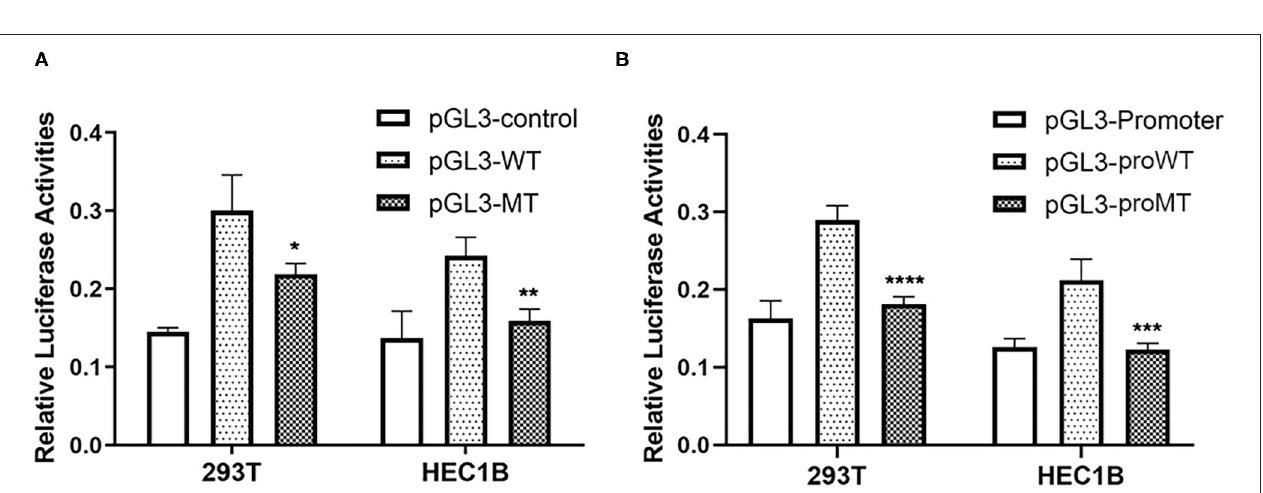
FIGURE 4 | The effect of rs72014506 on gene transcriptional activity. (A) The relative firefly luciferase activities were compared between insertion construct group (pGL3-WT) and deletion construct group (pGL3-MT) in 293T and HEC1B cell lines. Cells transfected with pGL3-MT exhibited a significantly lower luciferase activity as compared with cells transfected with pGL3-WT (* P < 0.05, ** P < 0.05). (B) Relative reporter gene expression in constructs containing MIR155HG promoter driven by DNA fragment harboring rs72014506 in 293T and HEC1B (pGL3-proWT, insertion allele; pGL3-proMT, deletion allele). Cell group transfected with constructs containing rs72014506 deletion allele showed lower firefly luciferase activities than that harboring insertion allele vectors (*** P < 0.001, **** P < 0.0001).